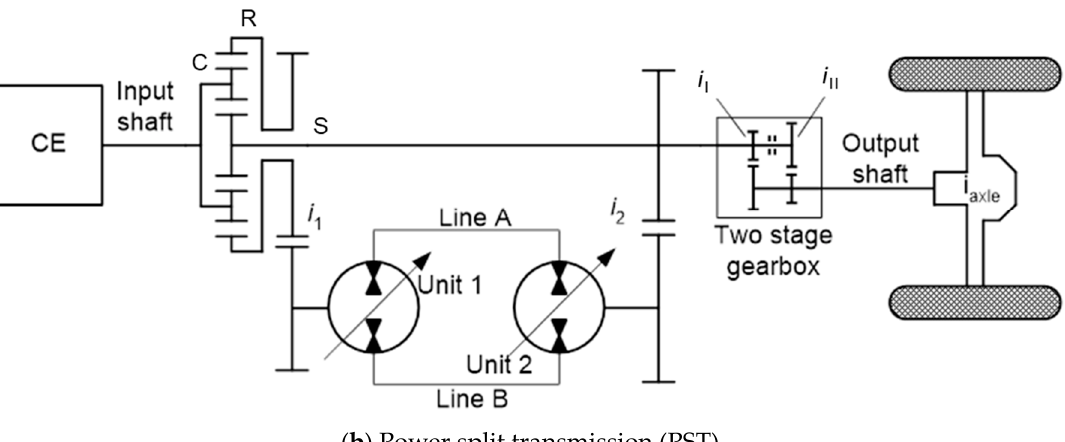
Figure 1. Schematics of the proposed wheel loader powertrains.